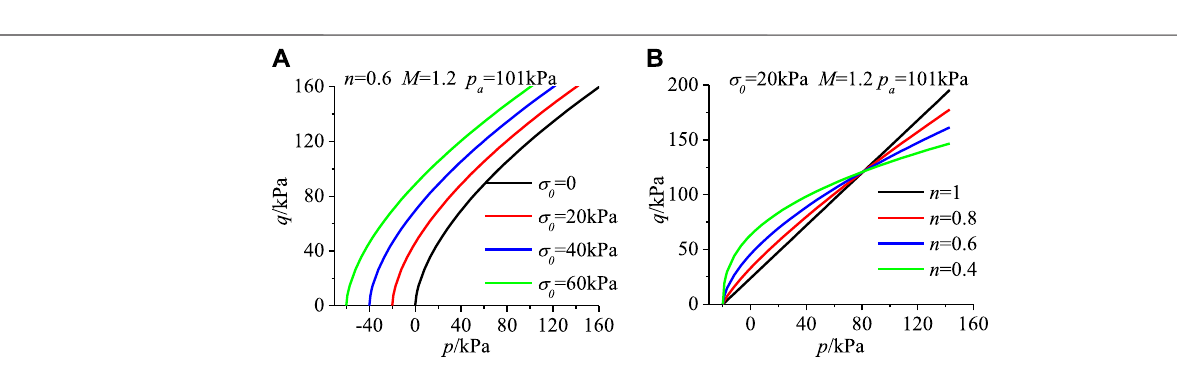
FIGURE 2 | UNS criterion variation with the parameter σ 0 and n on the meridian plane.